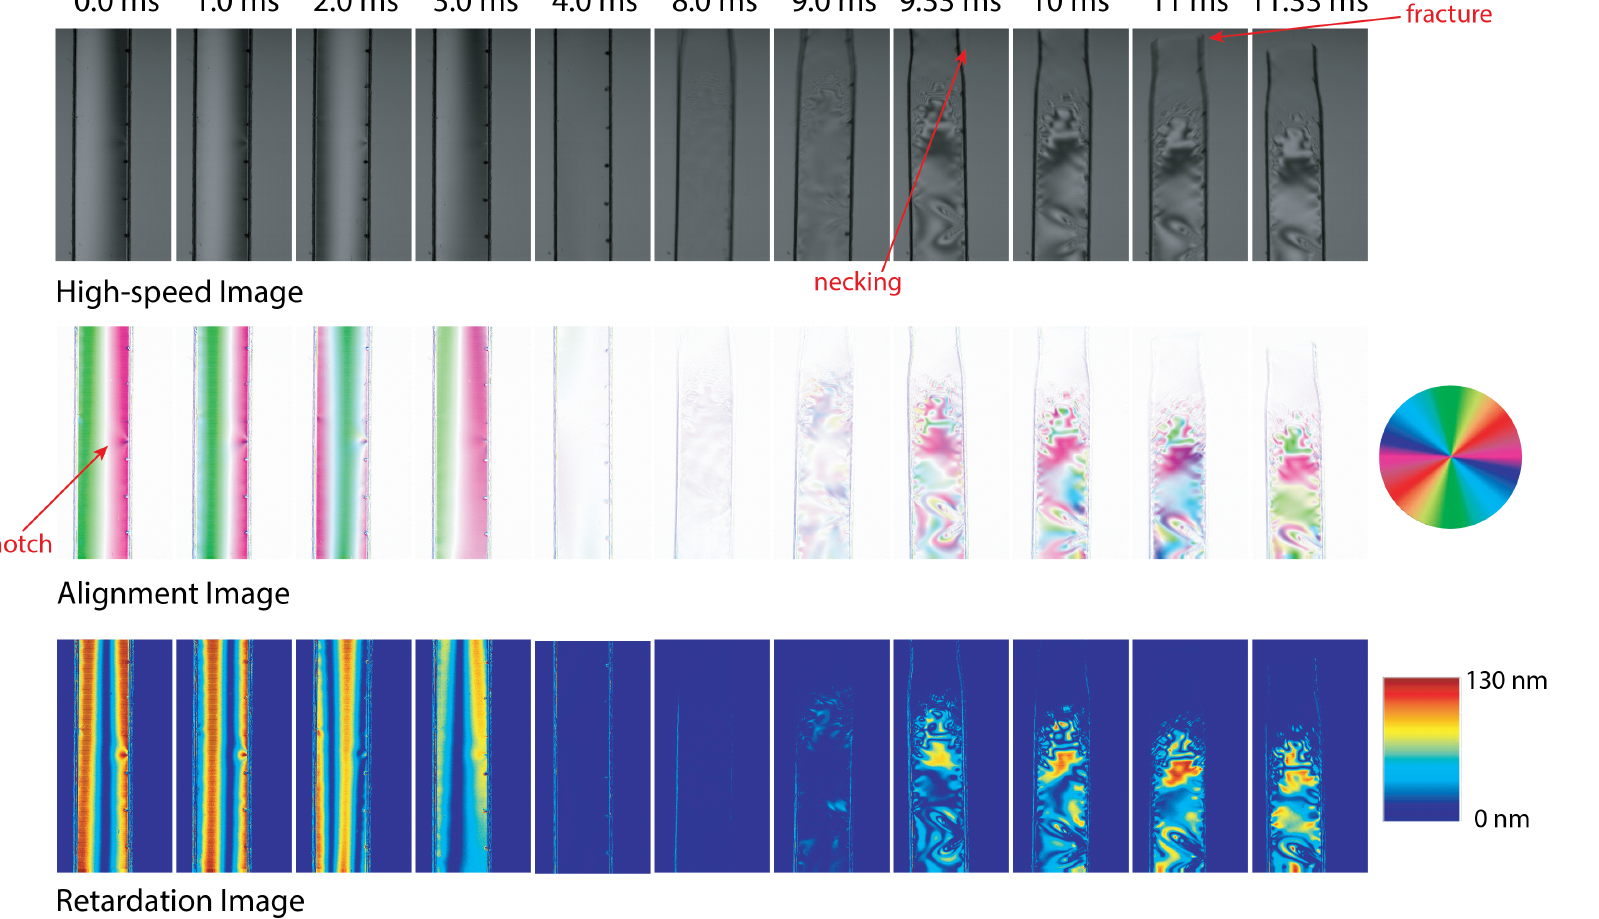
Figure 5. High-speed images recorded for a polycarbonate specimen using the high-speed polarization-filter-array camera and obtained optical axis alignment angle and retardation